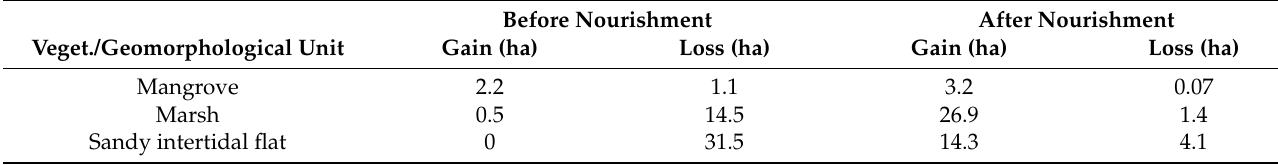
Table 2. Size of mangrove, saltmarsh, and sandy intertidal flat areas before and after the beach nourishment project. Margin of error is ± 0.0006 ha. Before Nourishment After Nourishment Veget./Geomorphological Unit Gain